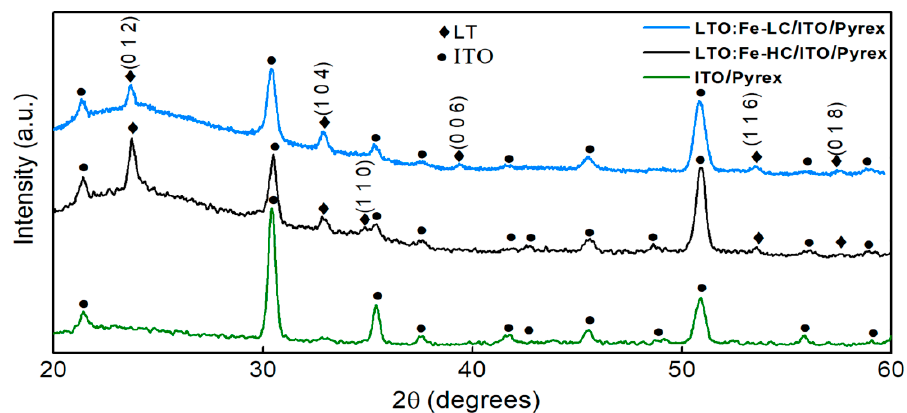
Figure 3. XRD pattern of ITO/Pyrex, LTO:Fe-HC/ITO/Pyrex, and LTO:Fe-LC/ITO/Pyrex systems.